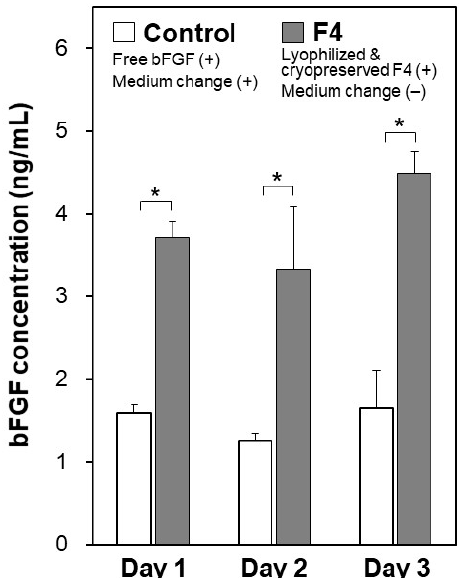
Figure 9. Concentrations of bFGF in the culture medium of human iPSCs on Days 1, 2, and 3 in medium-change-free continuous culture with the lyophilized and cryopreserved (3 months) F4 membrane (F4 group; gray bars) or in standard culture using bFGF-containing medium with daily medium refreshment (control group; white bars) (average + SD; n = 3; * p < 0.05).